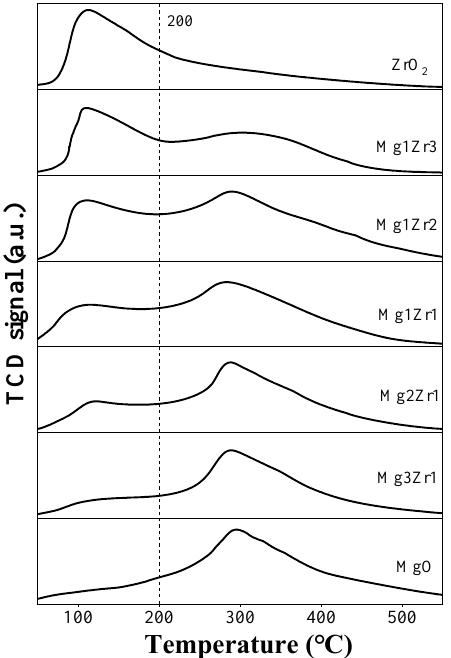
Figure 5. CO 2 -TPD of Mg-Zr composite oxides with different Mg/Zr ratios. Table 3. Texture properties and surface basicity of various Mg-Zr composite oxides.